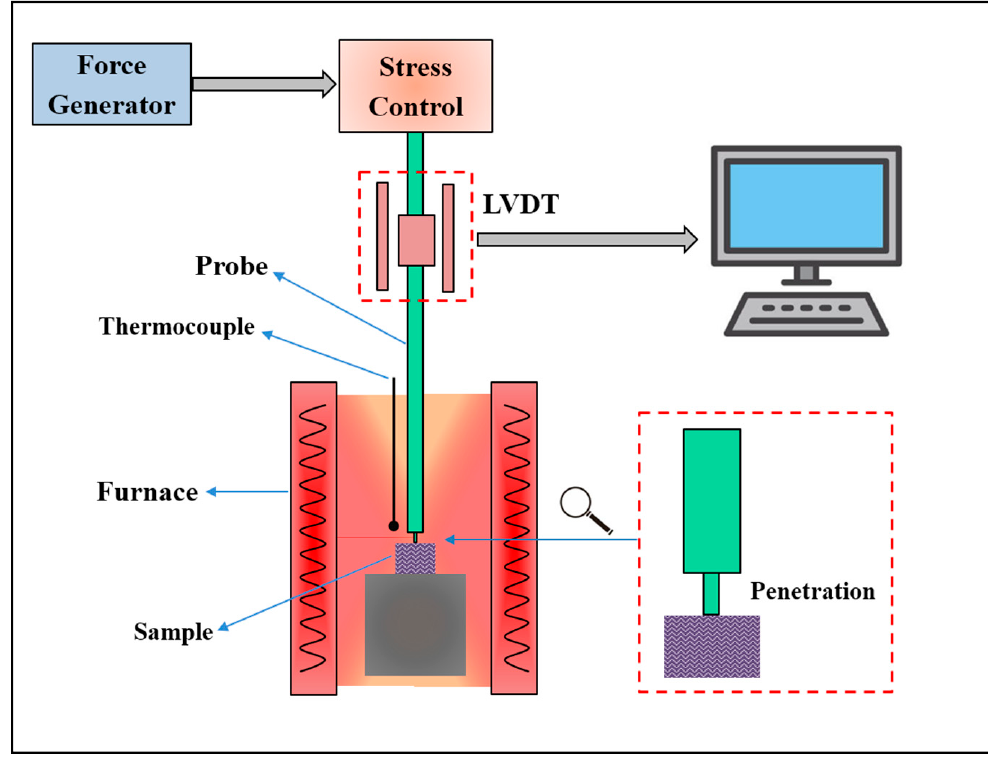
Figure 2. Schematic diagram of thermal mechanical analyzer (TMA) for isotropic pitch precursor characterization.